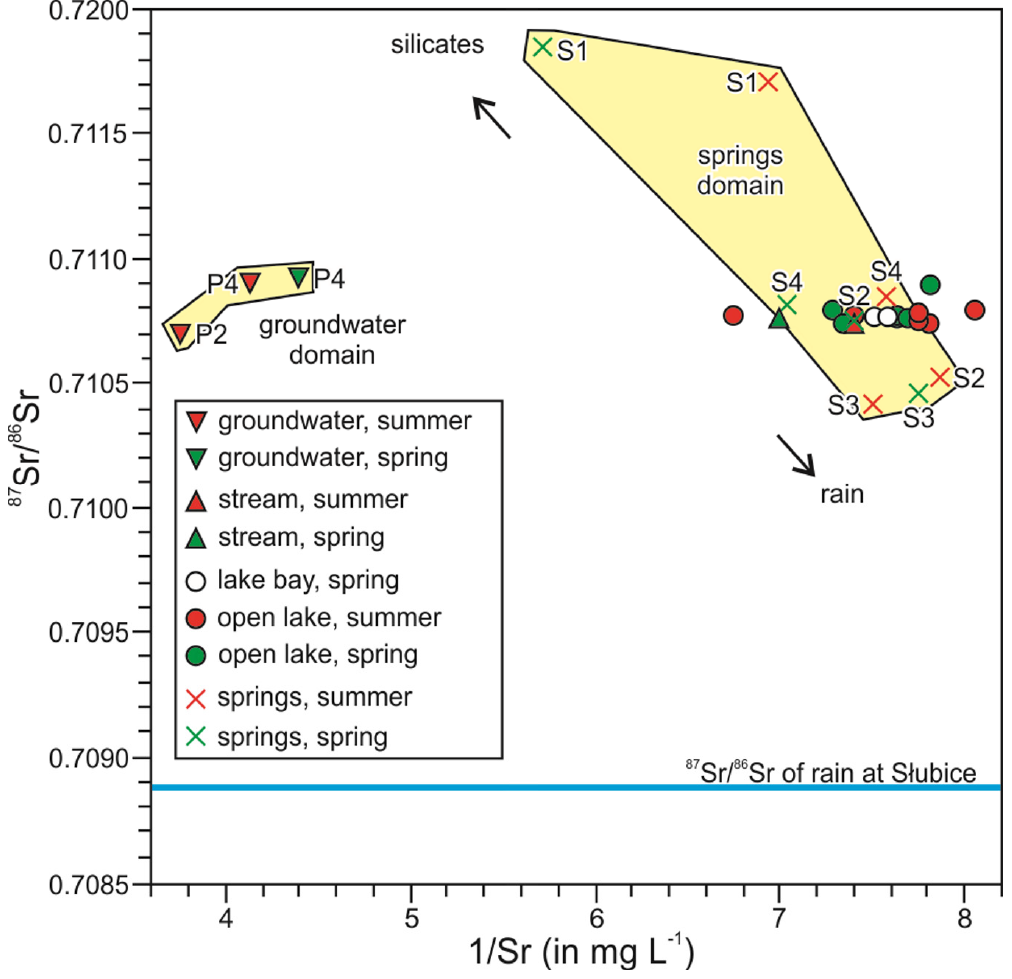
Figure 8. 87 Sr / 86 Sr versus 1 / Sr mixing diagram of the Lubi´nskie Lake hydrologic system. Note a binary mixing trend for the springs dataset and the deviation of data points for lake water from mixing paths between the springs.